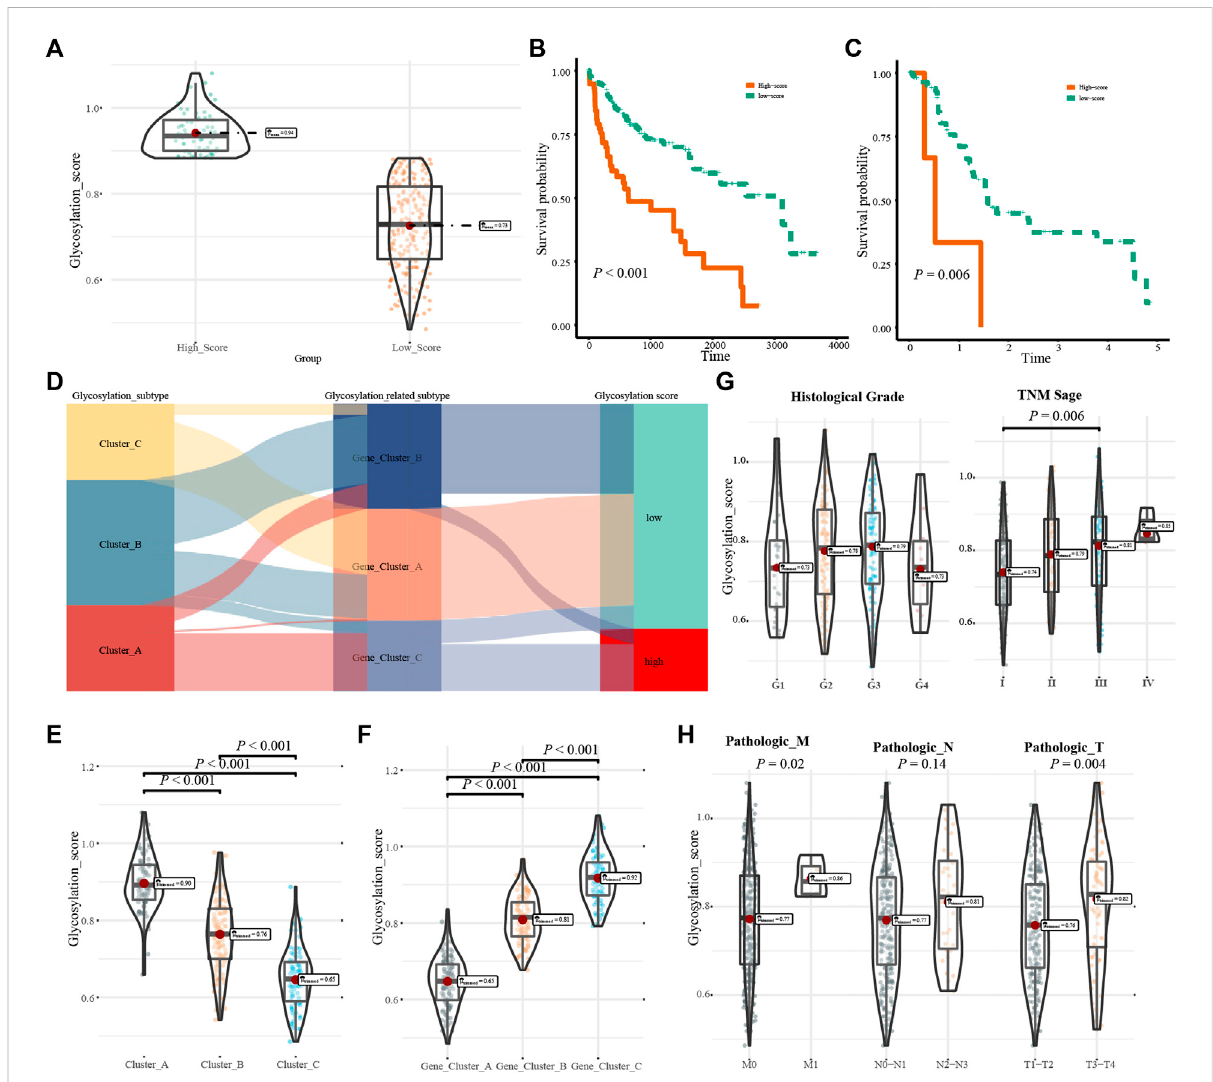
FIGURE 6 Clinical characteristics of the glycosylation score. (A) . Group information of glycosylation scores; (B) . Kaplan-Meier analysis of the high- and low-score in the TCGA-LIHC cohort; (C) . Kaplan-Meier analysis of high- and low-score in the GSE76427 cohort; (D) . Correspondence between glycosylation regulatory gene model, glycosylation-related model and glycosylation score; (E , F) . Relations between glycosylation regulator model, glycosylation-related model and glycosylation score; (G) . The relationship fo differentiation grade and TNM stage with glycosylation score; (H) . The relationship of tumor size, lymph node metastasis, and distant metastasis with glycosylation